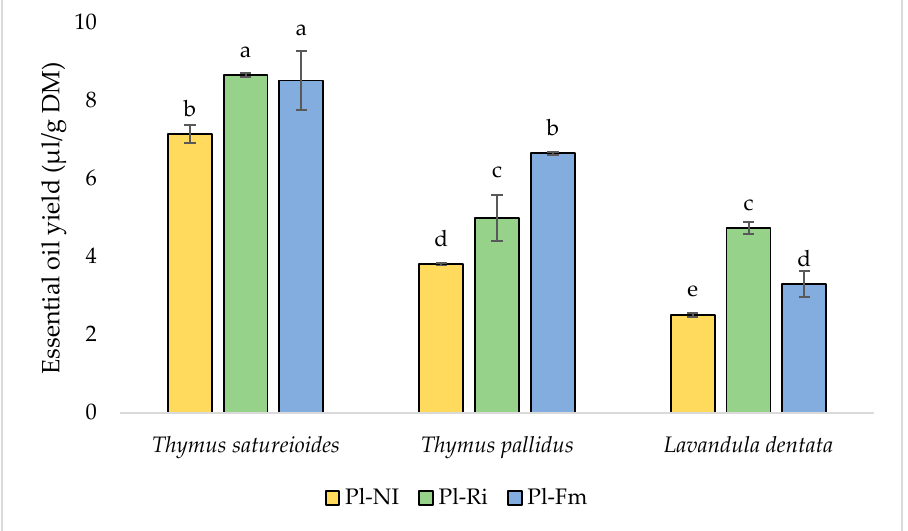
Figure 8. Essential oil yield distilled from Thymus satureioides (Ts), Thymus pallidus (Tp), and Lavandula dentata (Ld), non-inoculated (NI) or inoculated with Rhizophagus irregularis (Ri) or Funneliformis mosseae (Fm) after 4 months of culture under greenhouse conditions. Bars followed by the same letter are not significantly different according to Tukey’s HSD test ( p < 0.05).